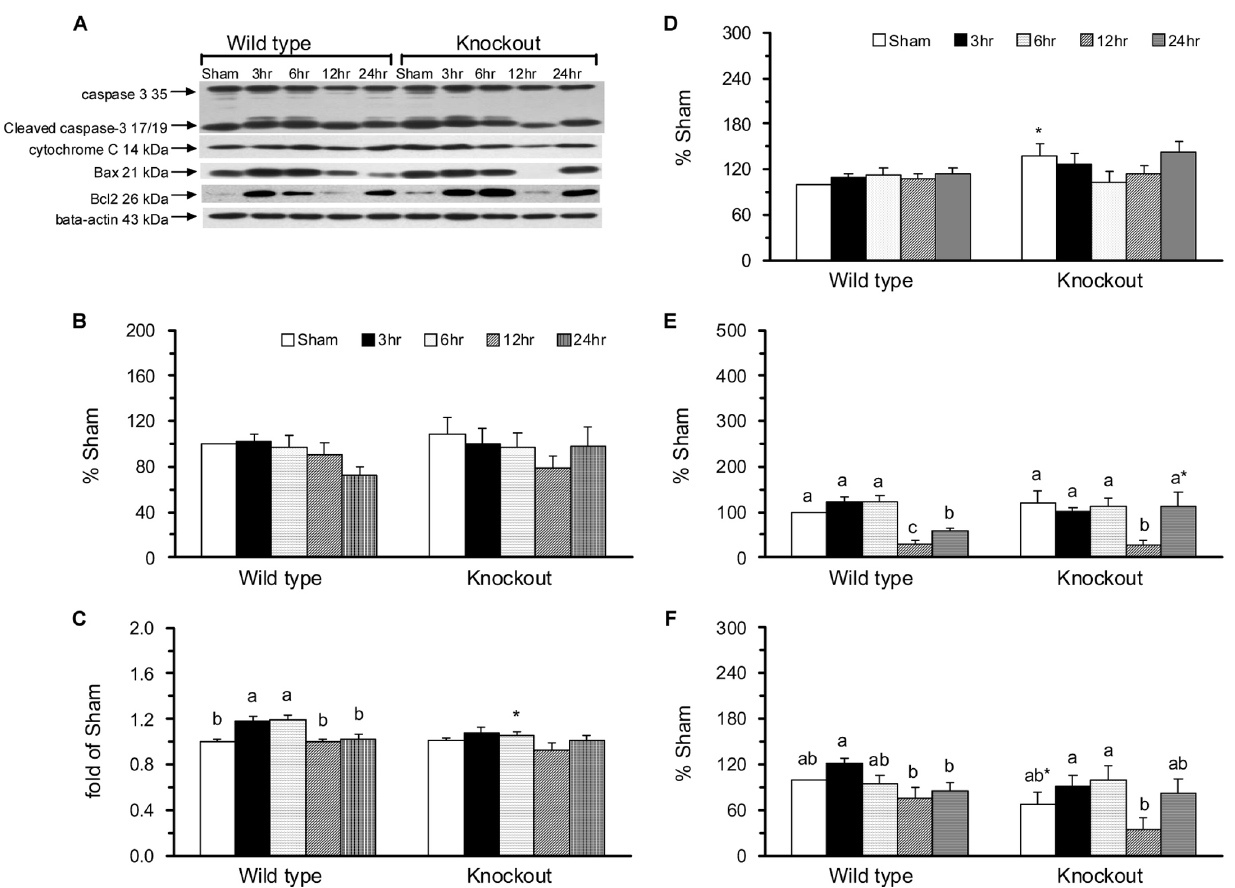
Figure 6. Molecules of the apoptotic intrinsic pathway in the jejunum. A western blot assay was employed to detect the protein expression of caspase 3 (Mw=35 kDa), cleaved caspase 3, cytochrome c, Bax, Bcl-2, and the internal control b -actin (A). The protein expression of activated, cleaved caspase 3 (B), the activity of caspase 3 (C), and the protein expression of cytochrome c (D), apoptotic protein Bax (E), and anti-apoptotic protein Bcl-2 (F). Protein quantification was carried out by densitometric analysis, normalized by the internal control b -actin, and calculated as the percentages of the WT-SH group. Means 6 SEM, n=10 for the WT groups and n=9 for the KO groups. *P , .05, KO vs. WT mice with sham operation or with intestinal IR at the same time point (Student’s t-test,). Values with different superscripts indicate significant differences within all of the time points in WT and KO mice, individually (one-way ANOVA with LSD, P , .05).